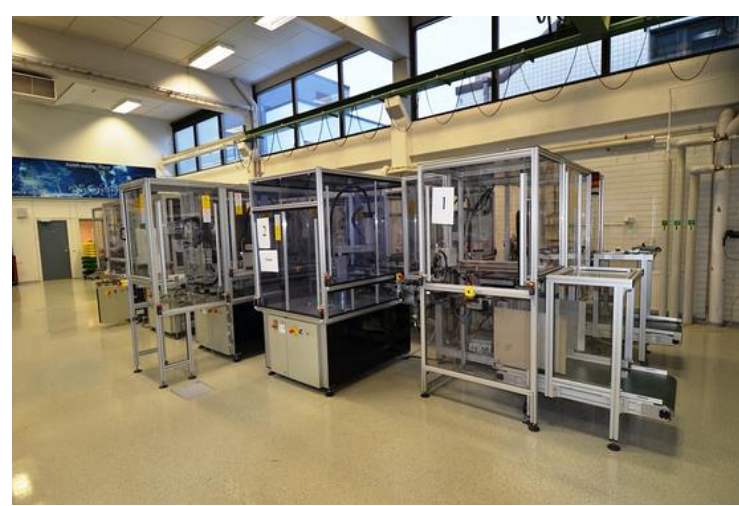
Figure 4 . The FASTory line. Figure 4. The FASTory